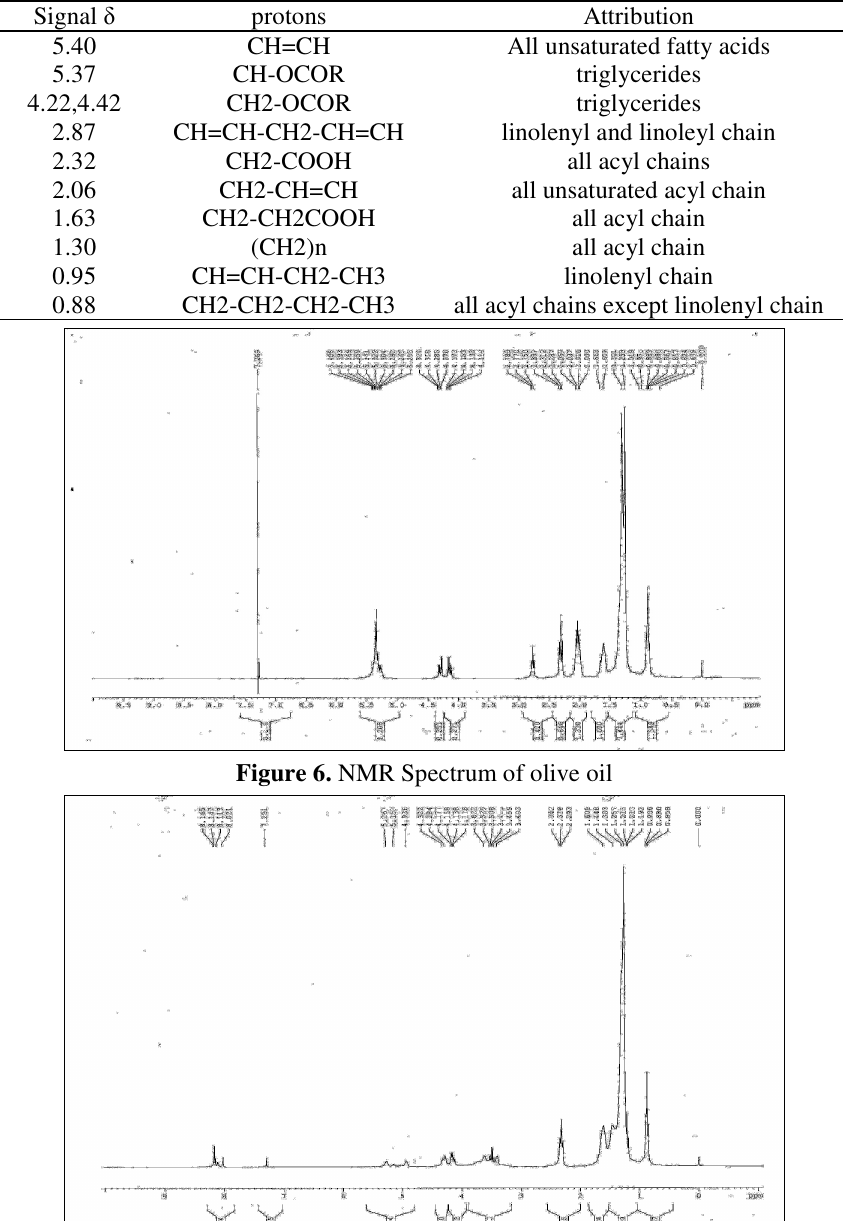
Table 2. Chemical shift and assignment of the signal in the 1 H NMR spectrum of olive oil in pyridine-d / chloroform – d solvent 5